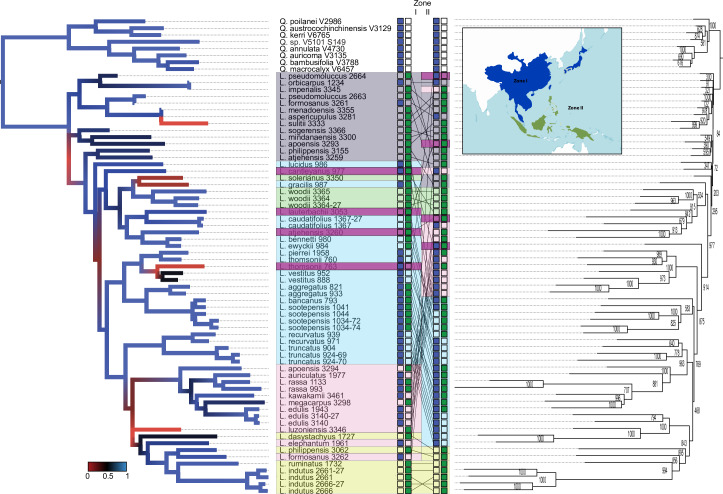
Comparison of PhyML results obtained from SNPs dataset (left) with the NJ tree (right) obtained using loci presence-absence data. Inset map shows the global distribution of Lithocarpus (blue+green) in reference to continental (blue) and insular (green) datasets. Clade colors and connecting lines indicate alternate placements of species in opposing trees. Numbers (right) and colors (left) on branches indicate nodal support values.